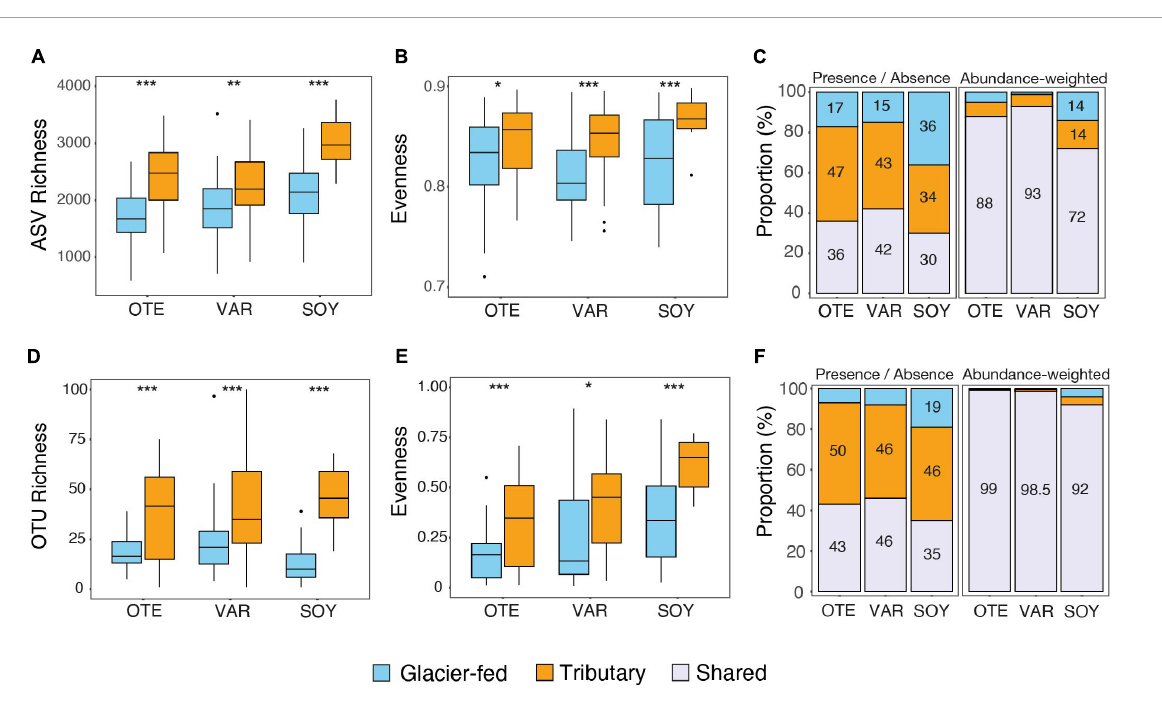
FIGURE2 Alpha Diversity for bacterial (16S) and phototrophic (18S) communities. Boxplots summarized for each glacier floodplain and stream category (A) Amplicon Sequence Variants (ASV) richness, (B) Pielou’s evenness for bacterial communities, (D) 18S rRNA OTUs richness, and (E) Pielou’s evenness for phototrophic communities. Box plots show the median (horizontal line), interquartile range (box height), 1.5 × beyond the interquartile range (whiskers), and outliers. A two-sample t -test established a significant difference between tributaries and GFSs for all three floodplains. (C) Bar plots summarized the proportion of (C) bacterial ASVs and (F) phototrophic OTUs exclusively present in GFS, TRIB, and the shared between these two stream types. Input for unweighted bar plots was presence/absence, while abundance-weighted bar plots used ASV